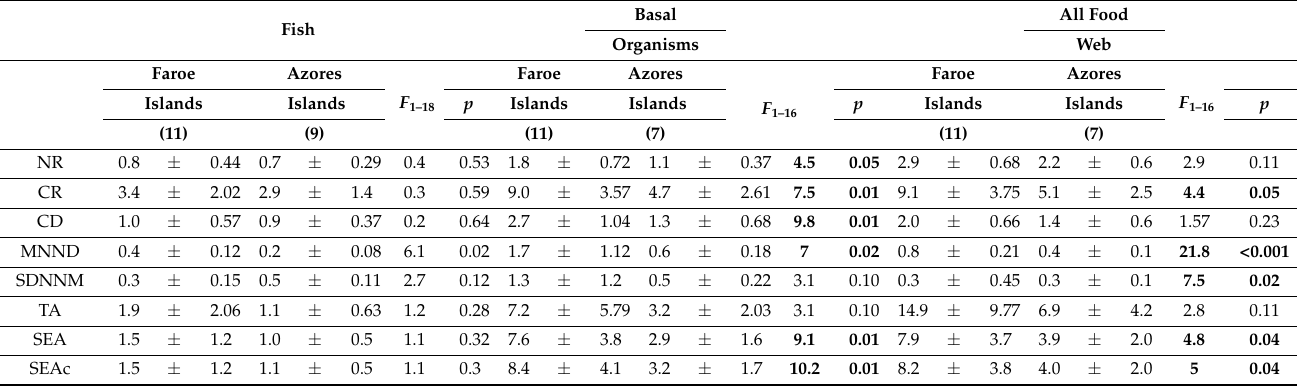
The maximum trophic position of fish did not differ between the two groups of is- Table 4. Comparison of food web metrics at the different trophic levels and for the entire food web in the two regions. The lands (t (1–18) = 1.47; p = 0.16), and neither did the mean trophic position of basal organisms number of lakes used in each analysis is given in brackets. For basal organisms, two lakes were excluded in the Azores (t (1–18) = 0.93; p = 0.36). The trophic position of fish was positively correlated with the trophic Islands due to absence of position of basal organisms. This relationship differed between the regions, having a